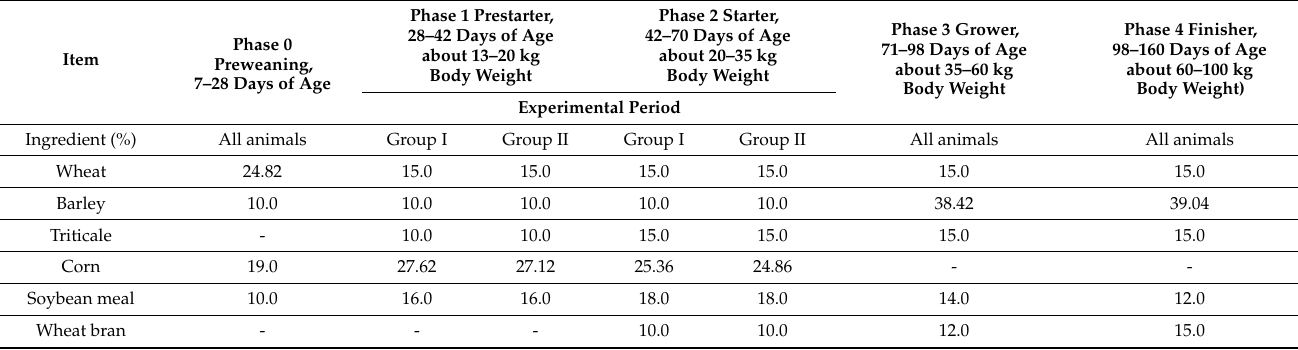
Table 1. Ingredients content of the pigs’ feed mixtures (as-fed